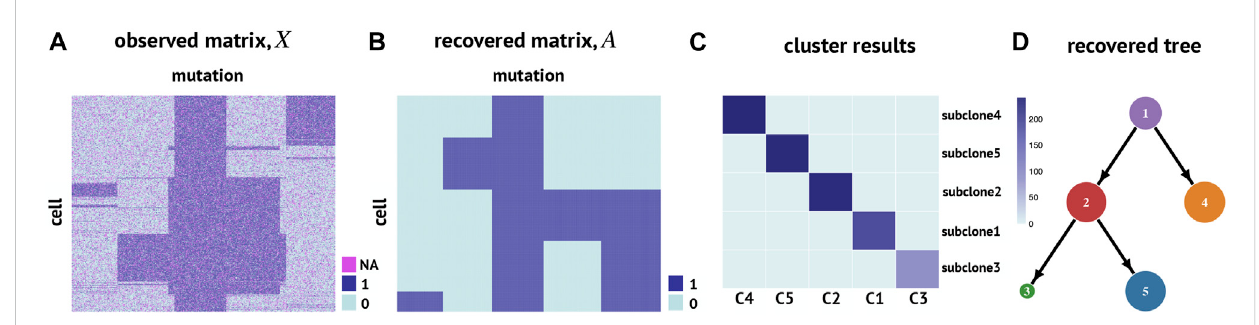
FIGURE 3 RobustTree reconstructs the tumor evolutionary tree on simulated single-cell DNA sequencing data. (A) Observed cell genotype matrix. (B) Recovered cell genotype matrix by RobustTree. (C) Heatmap shows the percentage of cells in each subclone (y-axis) distributed into real subclones (x-axis). (D) Subclone evolutionary tree reconstructed by RobustTree.